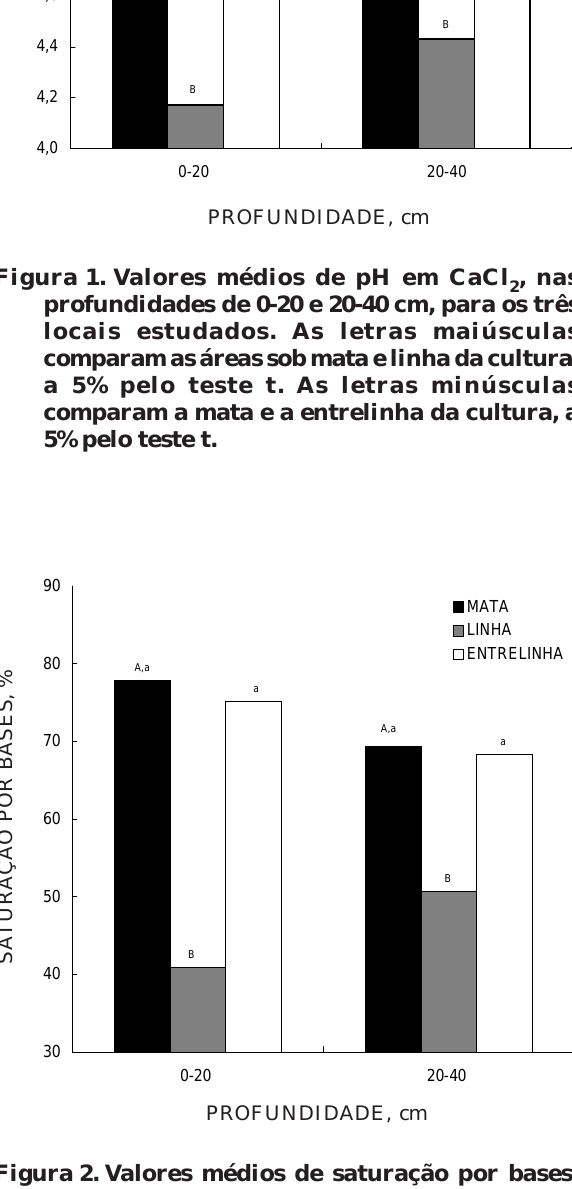
Figura 2. Valores médios de saturação por bases, nas profundidades de 0-20 e 20-40 cm, para os três locais estudados. As letras maiúsculas comparam as áreas sob mata e linha da cultura, a 5% pelo teste t. As letras minúsculas comparam a mata e a entrelinha da cultura, a 5% pelo teste t.